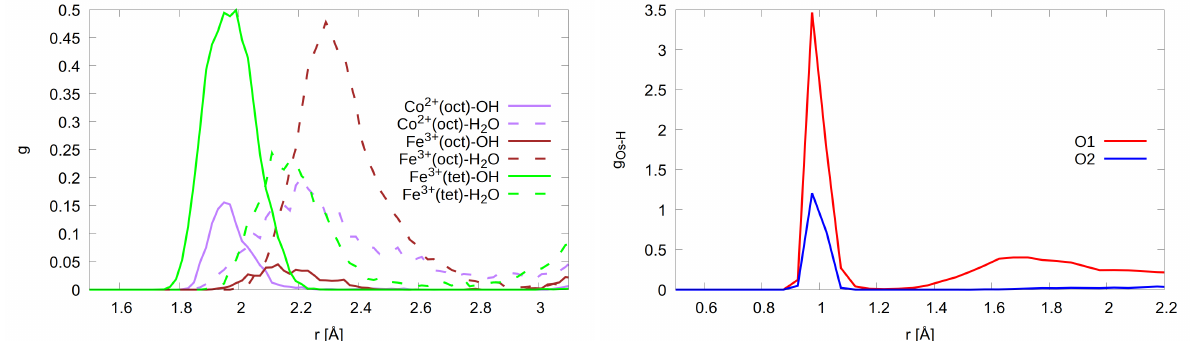
Figure 4. Radial distribution function of the adsorptions sites to the oxygen of water and hydroxide molecules ( left ) and the radial distribution function of the two lattice oxygen types (O1, O2) to hydrogen ( right ), A-termination.